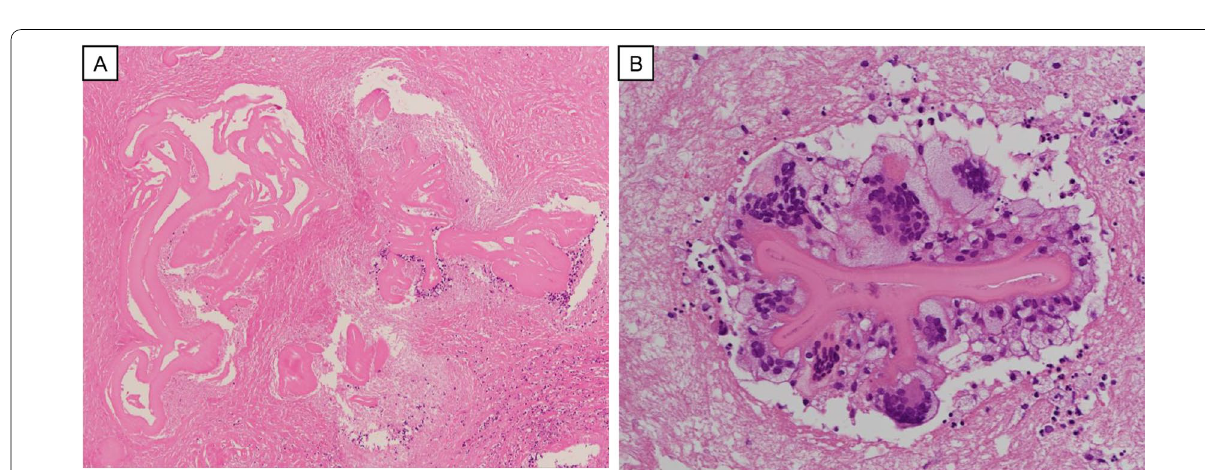
Fig. 5 A Pathological findings of the liver ( 100). The specimens stained with haematoxylin–eosin (H&E) showed alveolar echinococcosis vesicles × with laminar membranes. B Pathological findings of the cystic structure in the pericardium ( 200). The specimens stained by H&E showed alveolar × echinococcosis vesicles with laminar